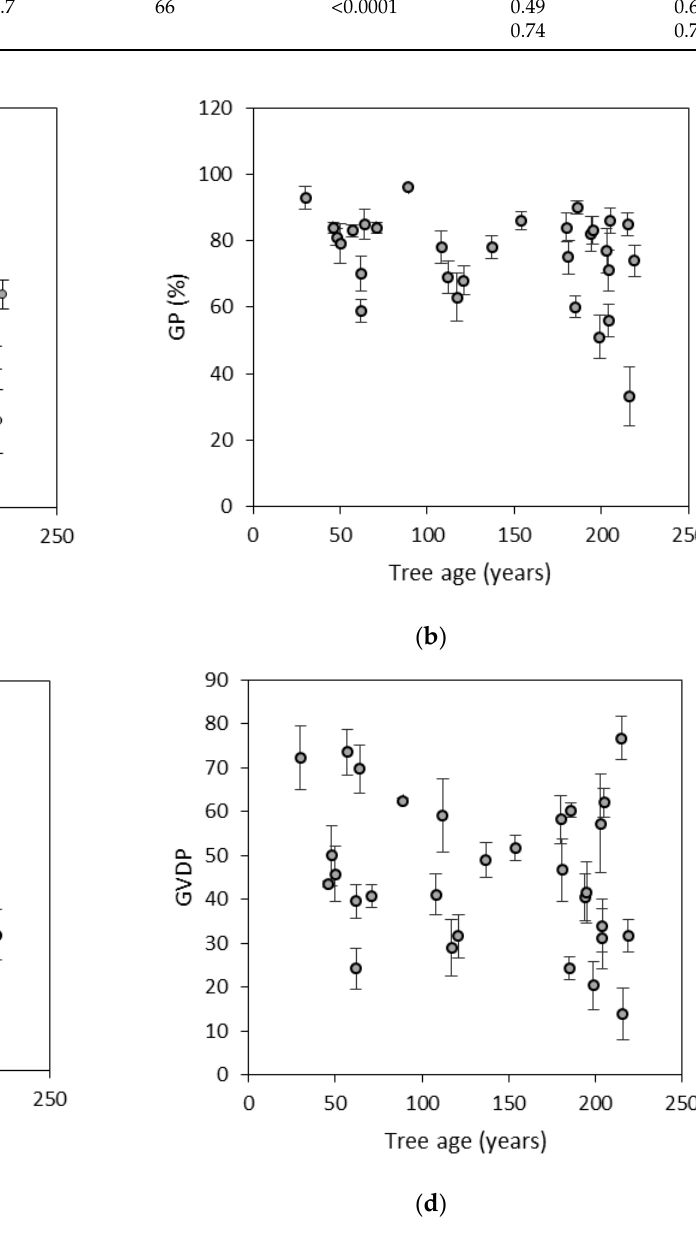
Figure 3. Mean values (±SE) (points) for the germination parameters of seeds along the range of tree age analyzed: ( a ) GE; ( b ) GP; ( c ) GVCZ and ( d ) GVDP. No fitted line is only shown as traits do not show a significant relationship with age.